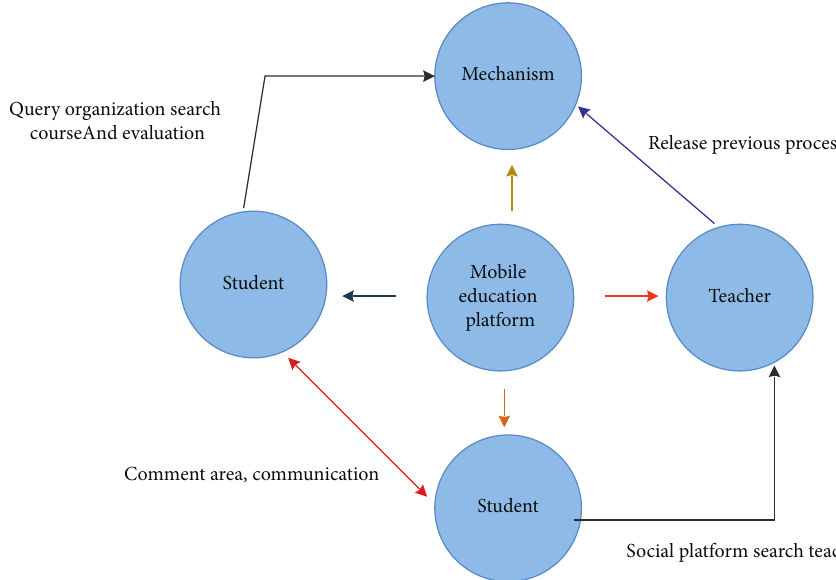
Figure 1: Online education